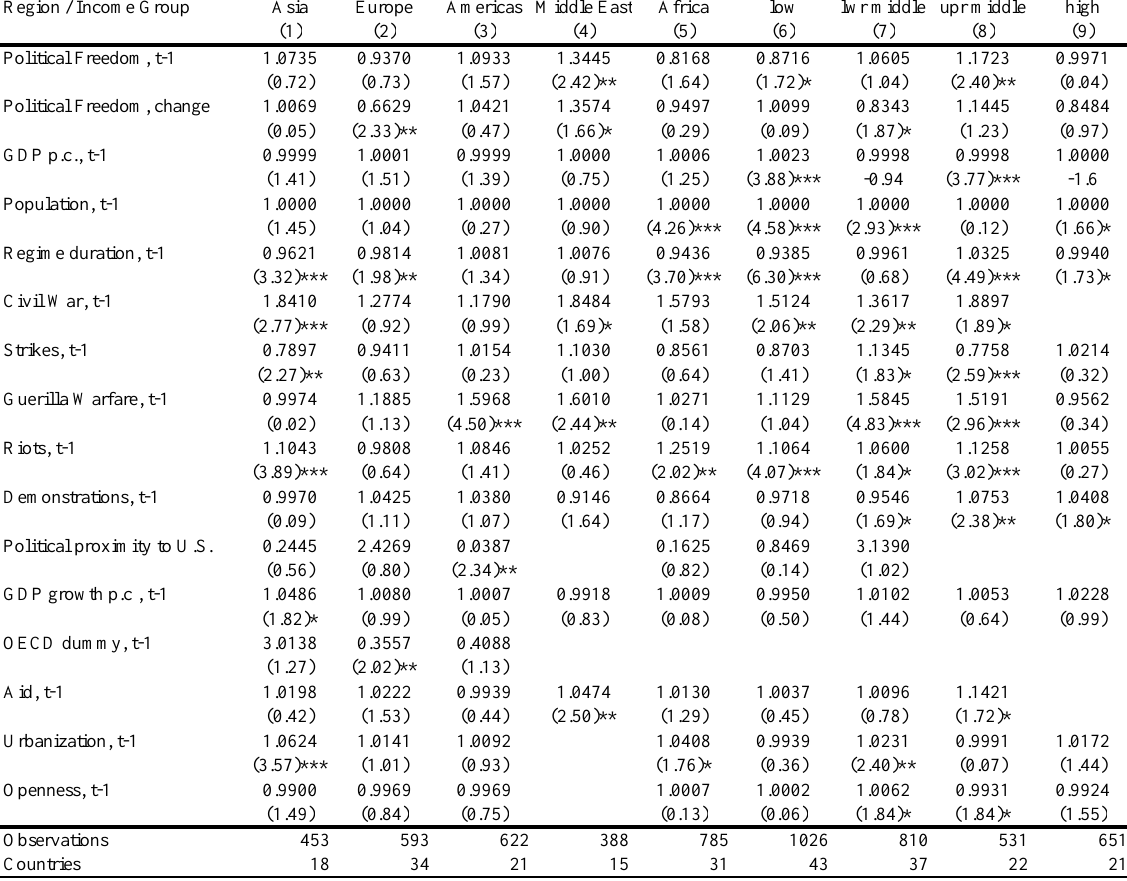
Table 4: Determinants of International Terror Events (Absolute Number), By Region and Income Groups, 1972-2003, Fixed-Effects Negative Binomial Panel Estimates Region / Income Group Political Freedom,